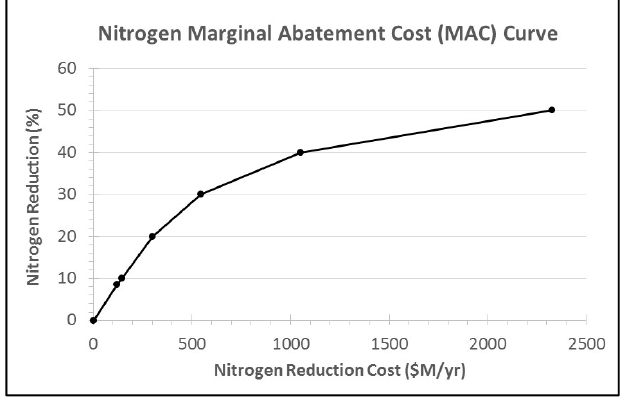
Figure 6. Nitrogen marginal abatement cost (MAC) curve in the Netherlands [50].